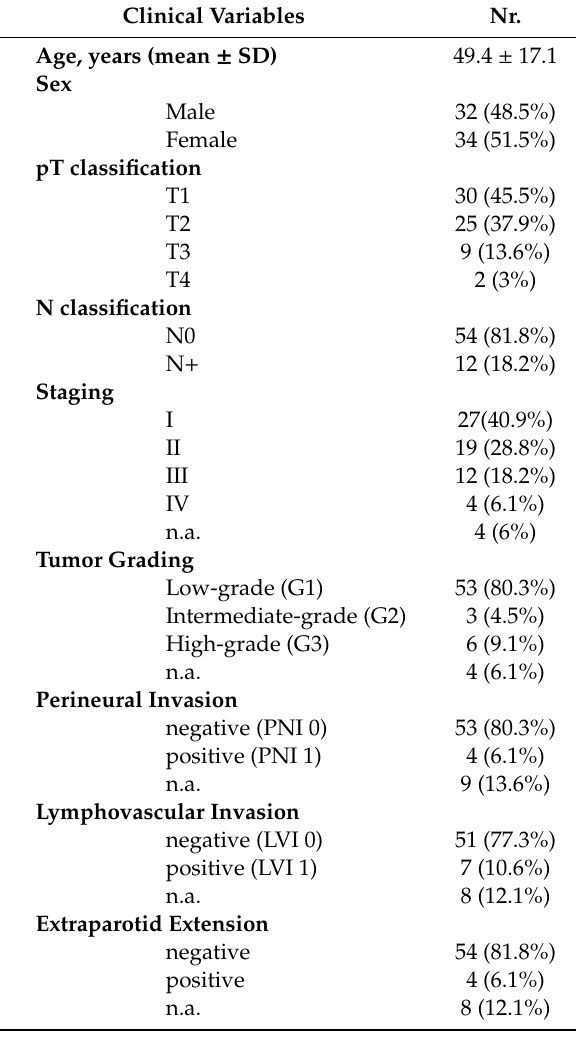
Table 1. Demographic and clinicopathological data of 66 patients with acinic cell carcinoma of the parotid